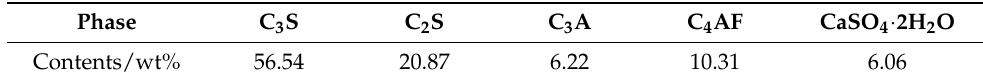
Table 2. Mineralogical composition of